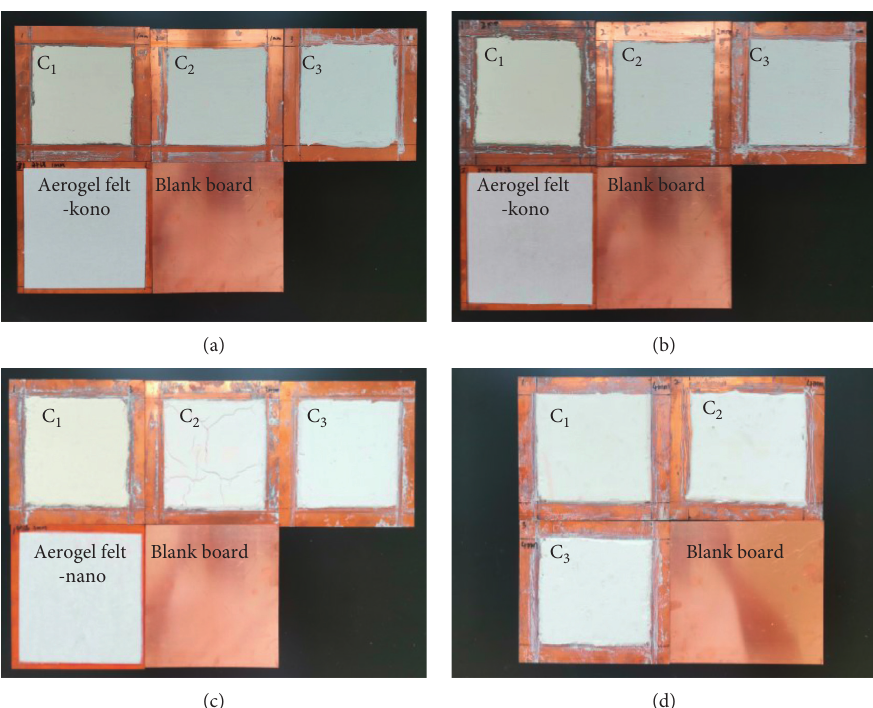
Figure 8: Tests plates. (a) Sample with 1 mm thickness. (b) Sample with 2mm thickness. (c) Sample with 3mm thickness. (d) Sample with 3mm